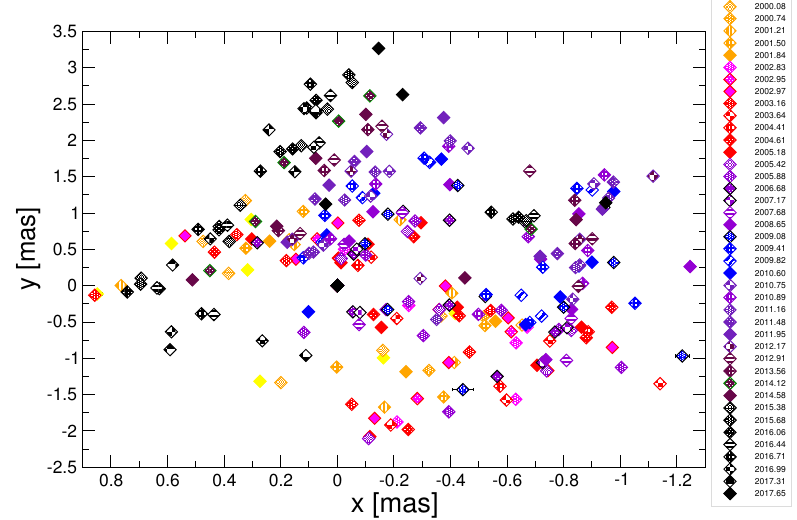
Figure 4. Jet components within the central region of 3C 84 between 1999.99 and 2017.65 (those within the red box in Figure